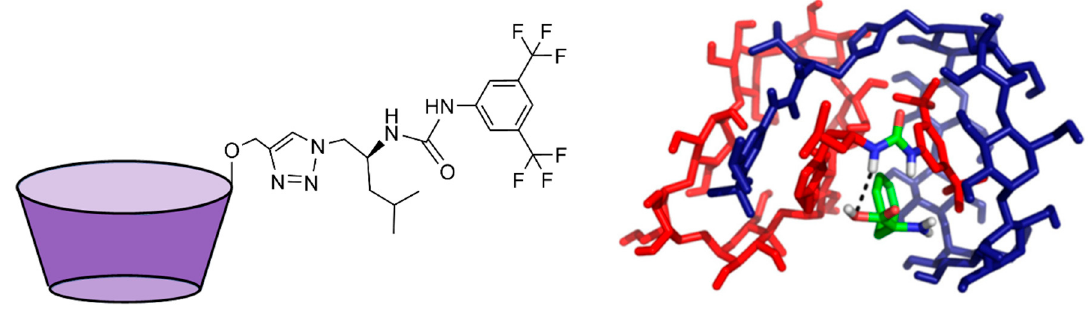
Figure 10. Structure of the receptor β -CDxU ( left ) and structure of the dimer that is formed upon complexation of L -Phe ( right ), reprinted with permission from [41]. Copyright (2017) Elsevier.